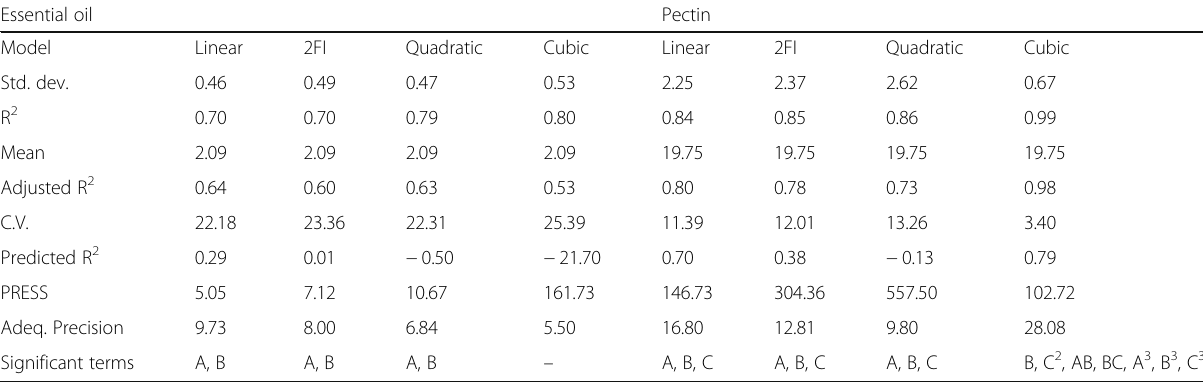
Table 4 Model selection for essential oil and pectin extraction Essential oil Pectin